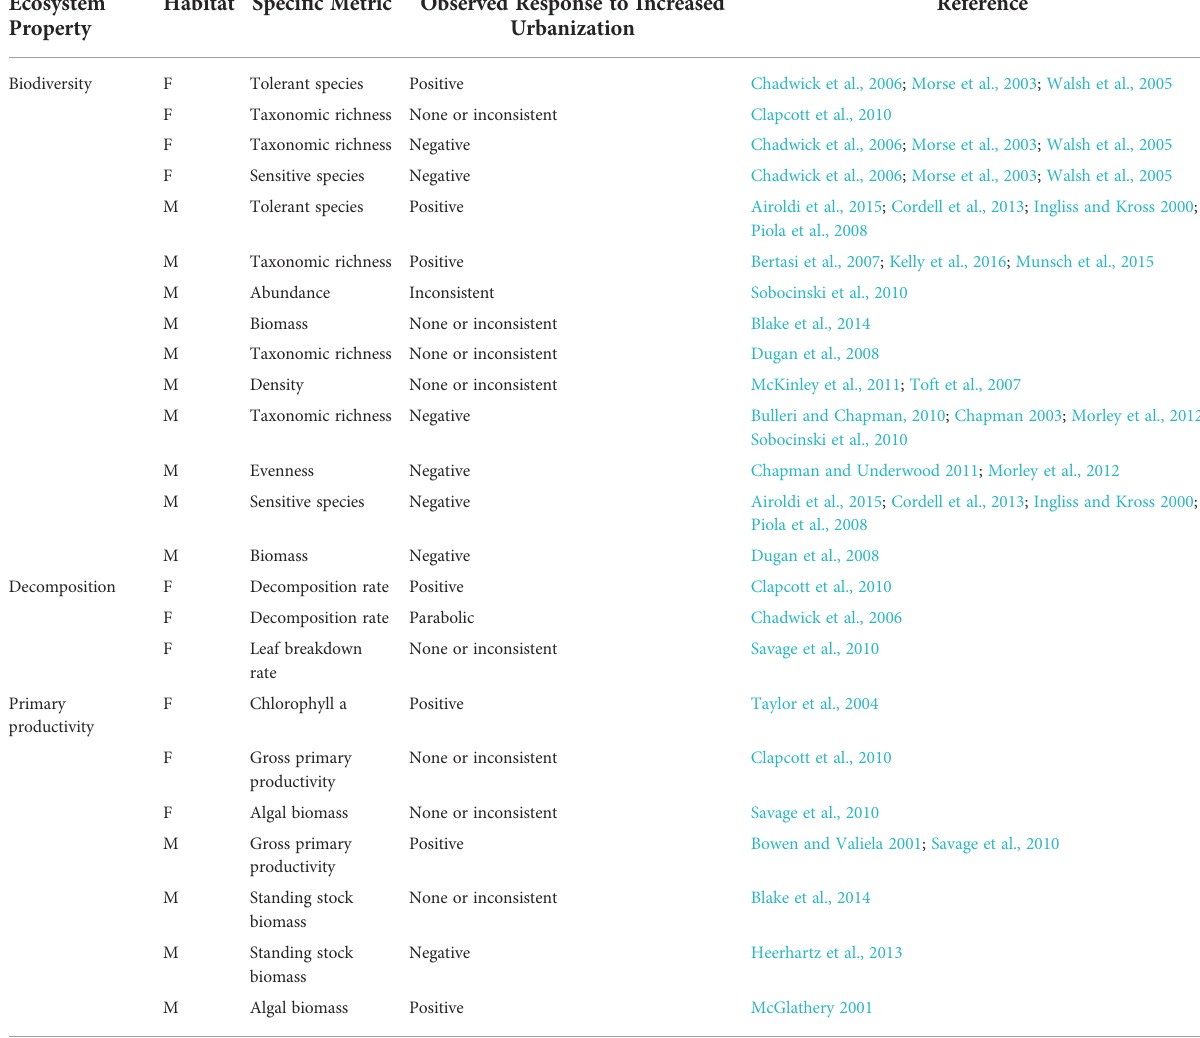
TABLE 1 Examples of how urbanization, de fi ned here as greater imperviousness and coastal armoring, can modify environmental processes, along with expected relationships between a variety of ecosystem properties. Ecosystem